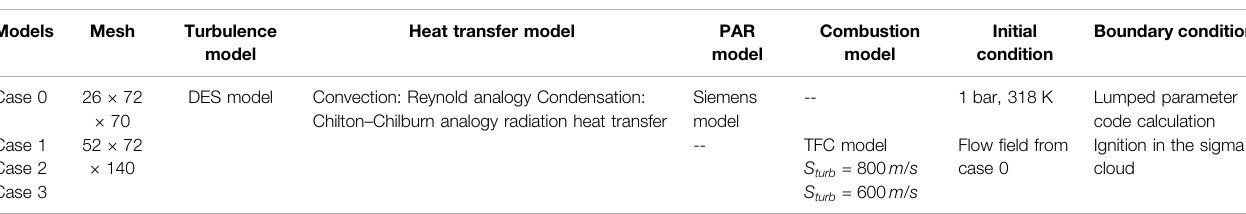
TABLE 2 | Summary of physical model and initial and boundary